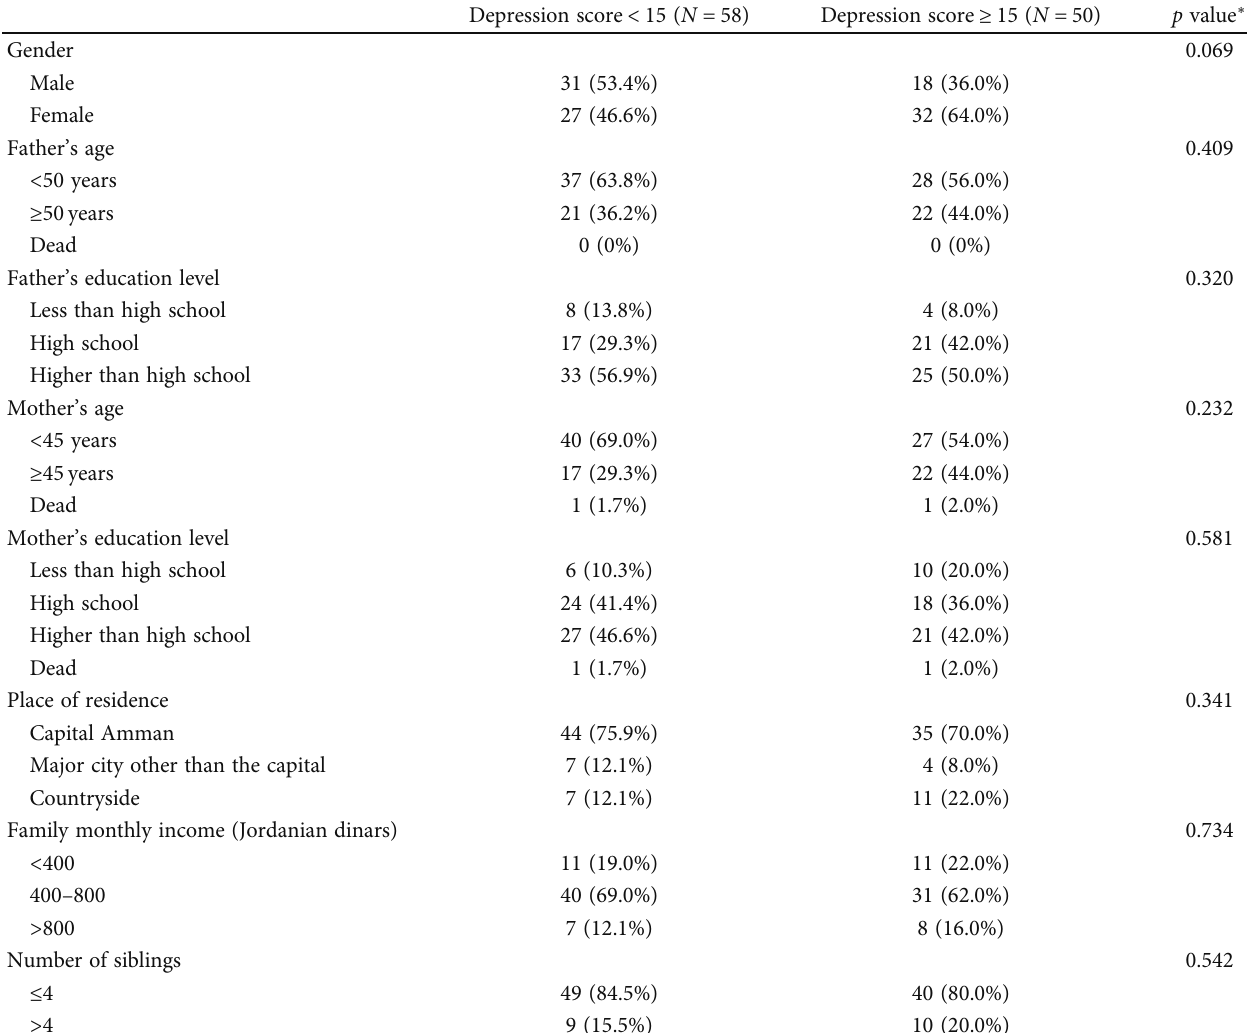
Table 1: Di ff erences in the demographic and socioeconomic characteristics between the 2 groups of patients in the